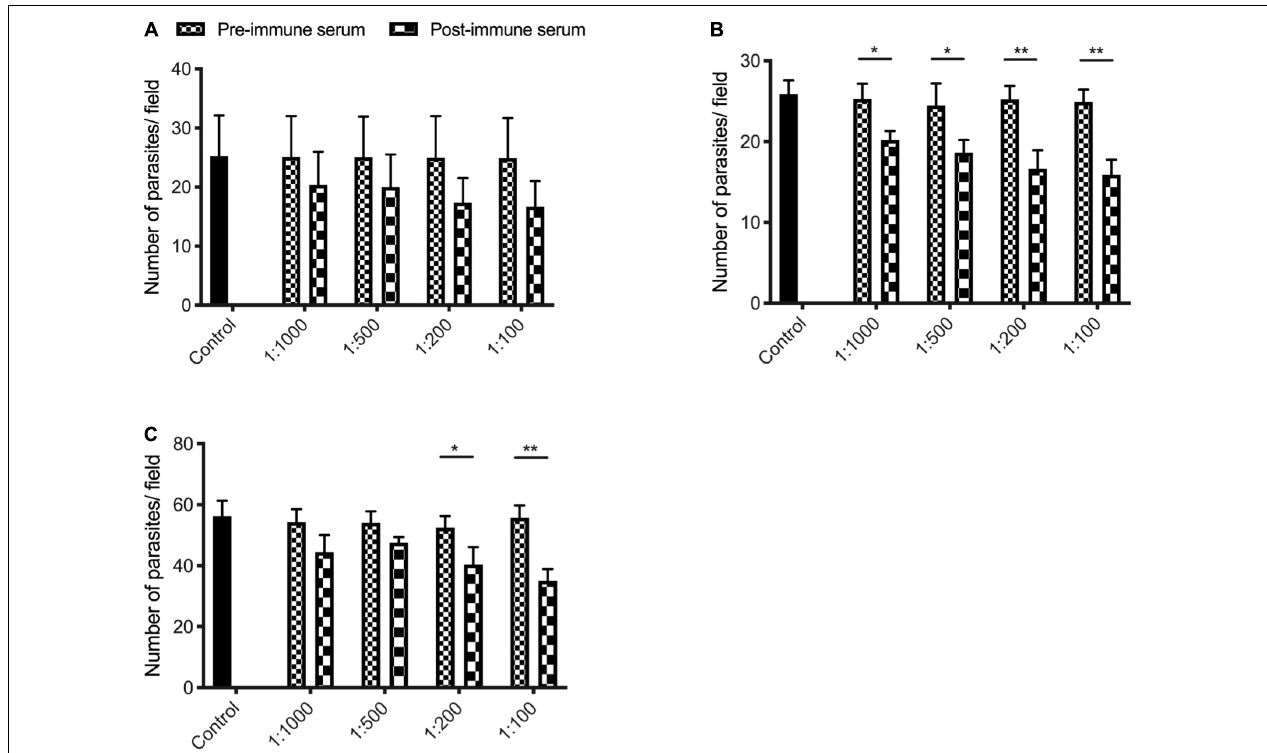
FIGURE 6 | Inhibition efficiency of immune sera against INS-21 (A) , INS-23 (B) , and the combination of the two (C) on C. parvum invasion. Inhibition efficiency of C. parvum invasion by immune sera against INS was measured in HCT-8 cell culture. Data presented are mean ± SD from three independent experiments for both the expression and neutralization studies. Statistical analysis was performed using unpaired t -test for pairwise comparisons (* P < 0.05; ** P <